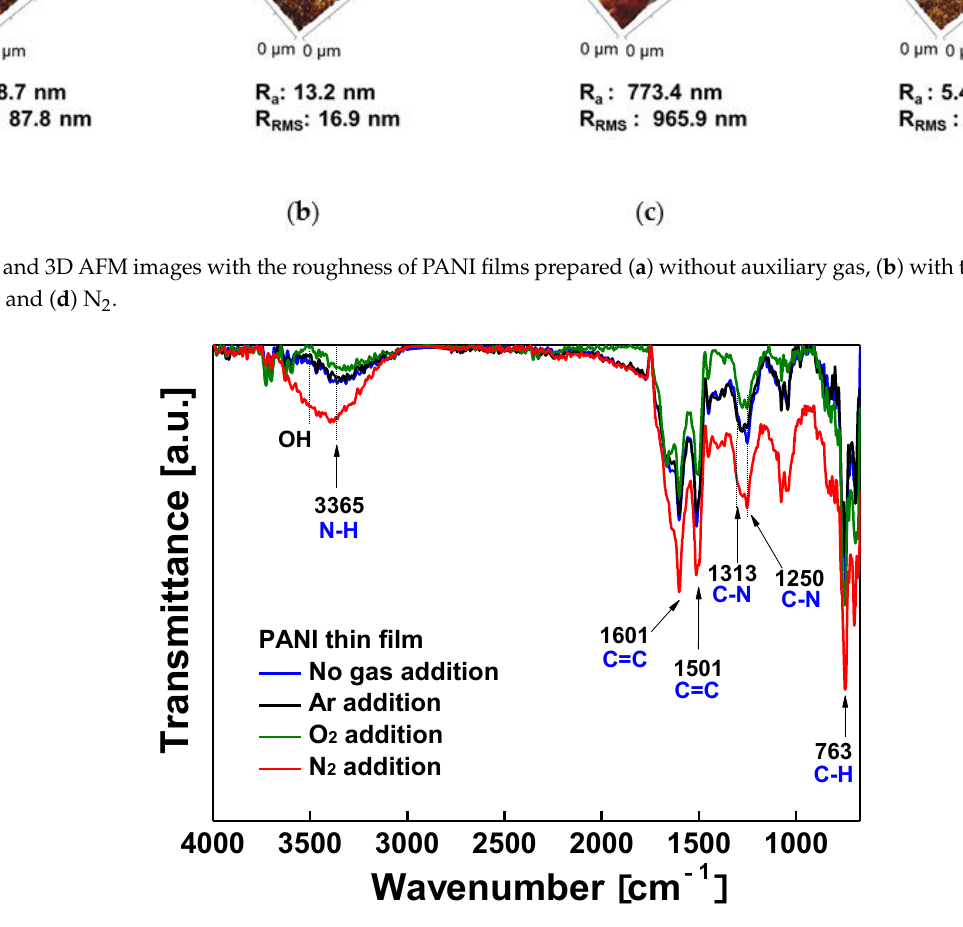
Figure 7. Comparison of ATR-FTIR spectra of PANI films synthesized with and without auxiliary gas addition (Ar, O 2 , and N 2 ).